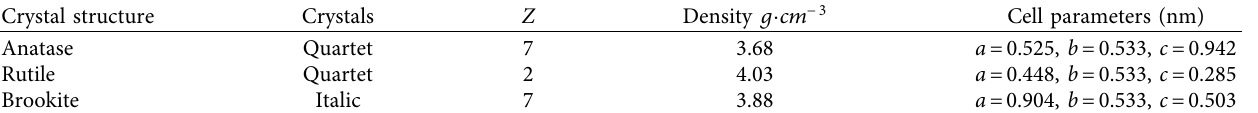
Figure 1: Titanium dioxide crystal structure. (a) Rutile structure. (b) Anatase structure. Table 1: Related parameters of titanium dioxide crystal